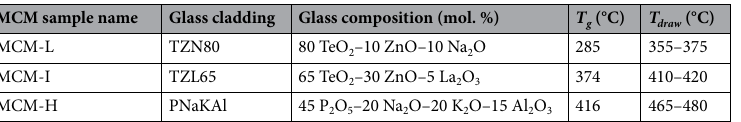
Table 3. Composition, glass transition temperature T g and thermal drawing temperature range T draw of the different glasses used as claddings for the MCM applied to PEEK.